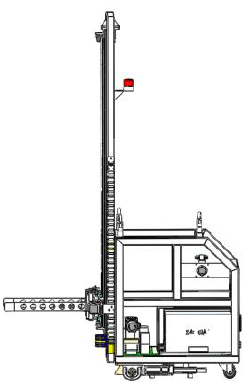
Figure 2. The di ff erential drive fork-type AGV model. Figure 2. The differential drive fork-type AGV model. Figure 2. The differential drive fork-type AGV model.